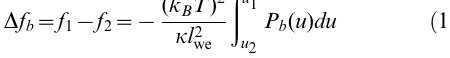
( u ) ~ ( u z c 2 u 2 z c 3 u 3 ) = b